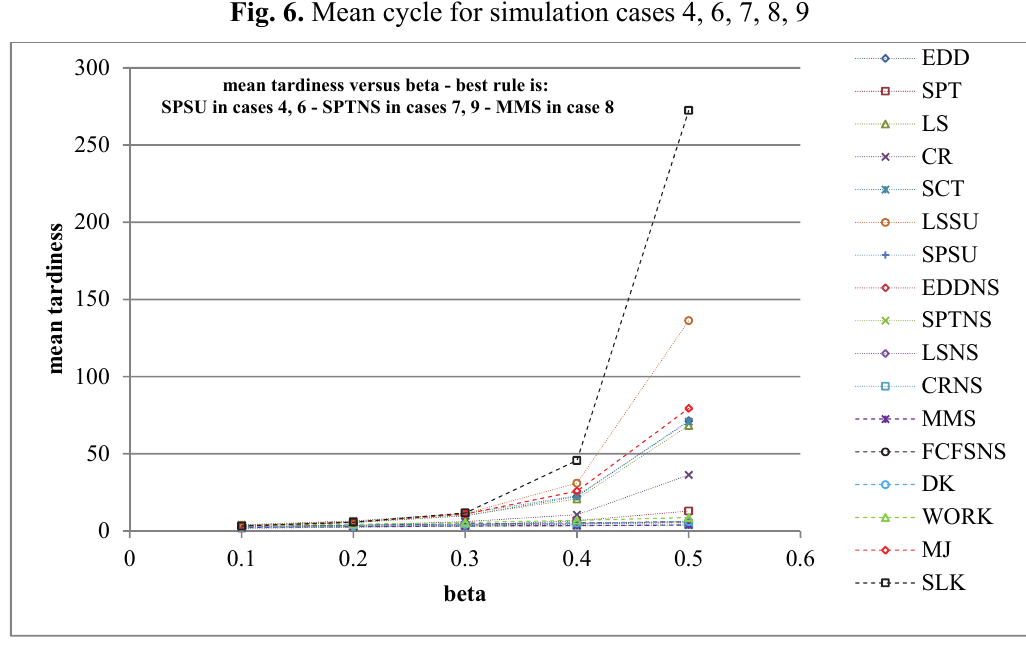
Fig. 7. Mean tardiness for simulation cases 4, 6, 7, 8,